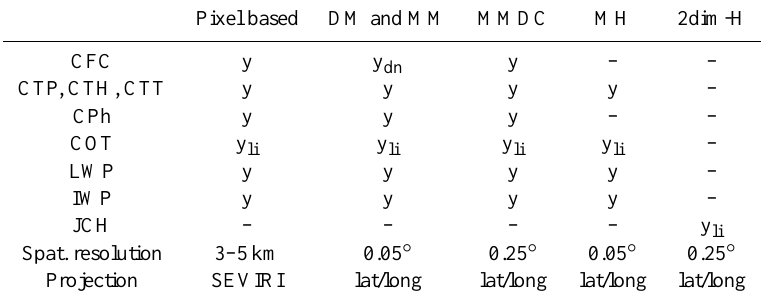
Table 1. Overview of CLAAS cloud products (indicated by “y”) per cloud variable and processing level: pixel-based products on hourly resolution, daily mean (DM), monthly mean (MM), monthly mean diurnal cycle (MMDC) and monthly histograms (MH stands for 1-D histograms, JCH for two-dim. COT/CTP histograms). Subscript “dn” denotes that an additional separation for day and night-time values is available and “li” denotes an additional separation for liquid and ice clouds.